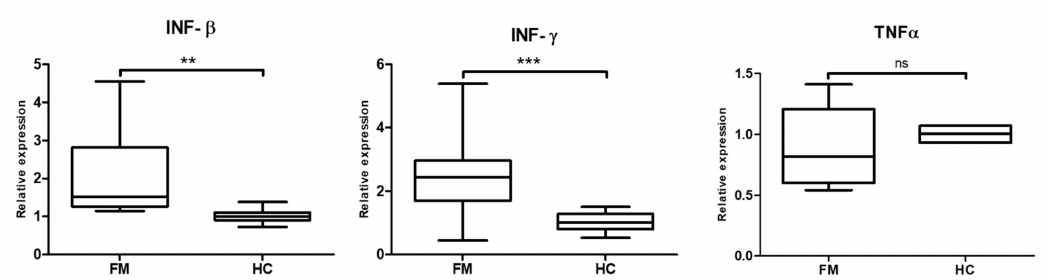
Figure 2. INF- β and INF- γ levels are increased and TNF- α are una ff ected in FM patients showing increasedHERVlevels. RT-qPCRamplificationofINF- β andINF- γ andTNF- α areshown(N = 14 / group); (*** p < 0.001; ** p < 0.005); ns (non-significant). Primers sets used are detailed in Table 2 and conditions described in Methods. Relative expression was calculated as 2 − ∆∆ C t values using GAPDH levels as reference. Group means and SEM values are